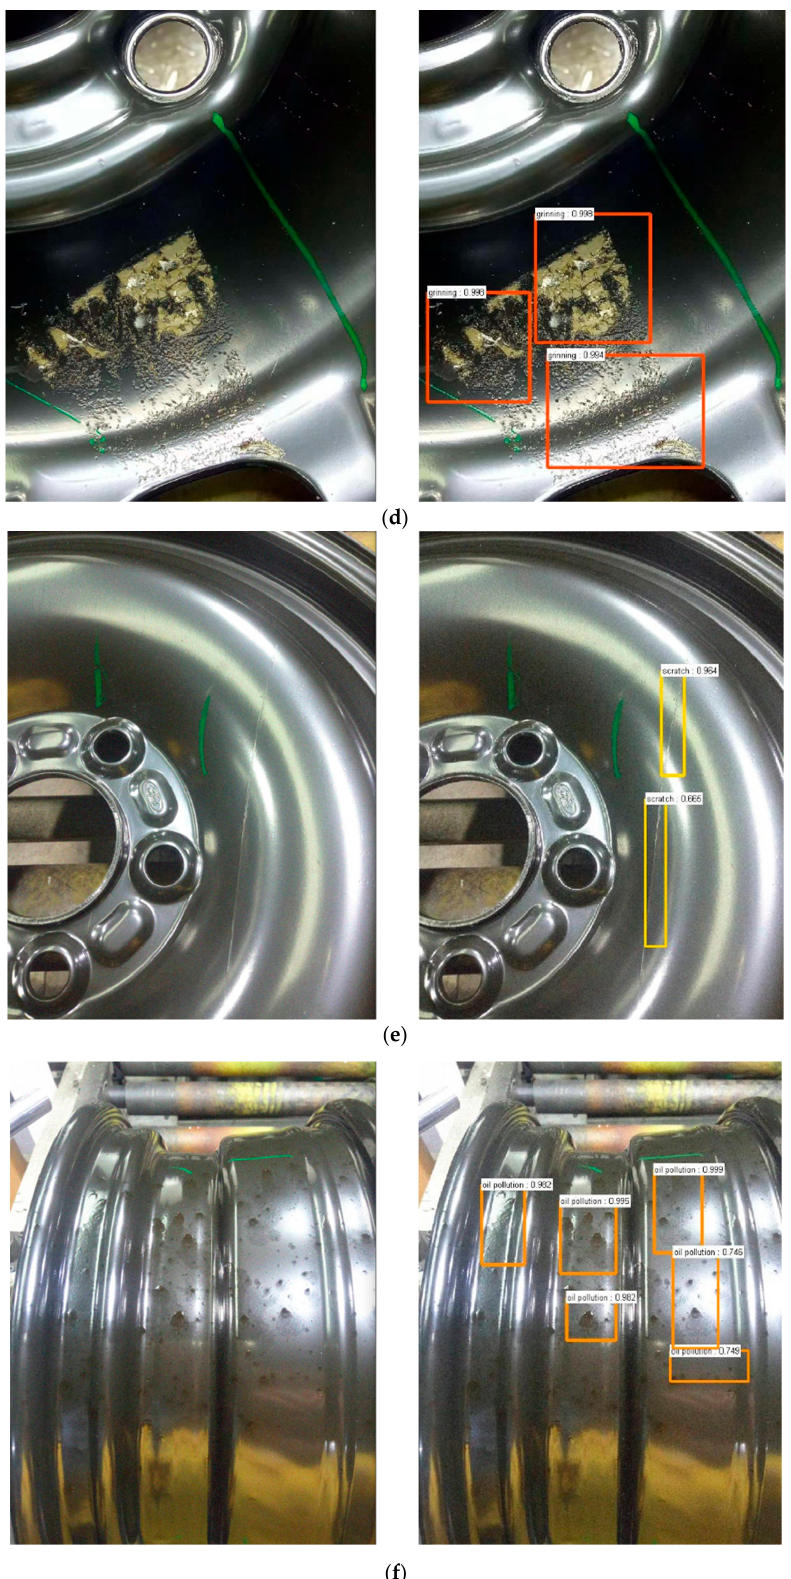
Figure 11. Testing results for six additional images. ( a ) oil pollution and block; ( b ) block and oil pollution; ( c ) block; ( d ) grinning; ( e ) scratch; ( f ) oil pollution.